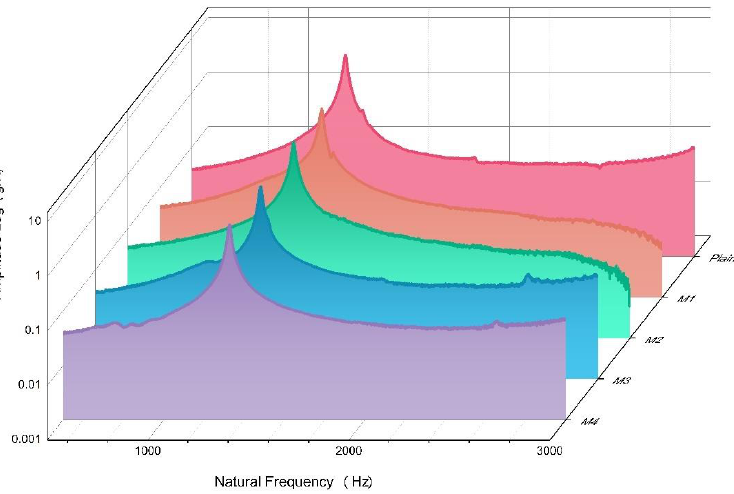
Figure 8. The relationship between amplitude and natural frequency of each mix during the modal test.